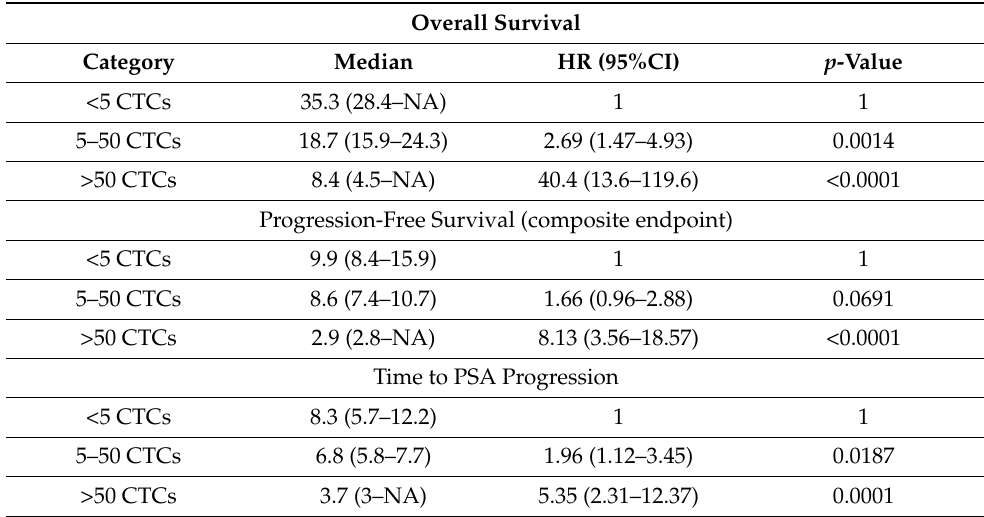
Figure 1. Kaplan–Meier plot for ( A ) overall survival; ( B ) progression-free survival and ( C ) time to PSA progression according to baseline CTC count. Abbreviations: CTC, circulating tumor cell; m, months. Table 3. Association of survival outcomes and baseline CTC count.